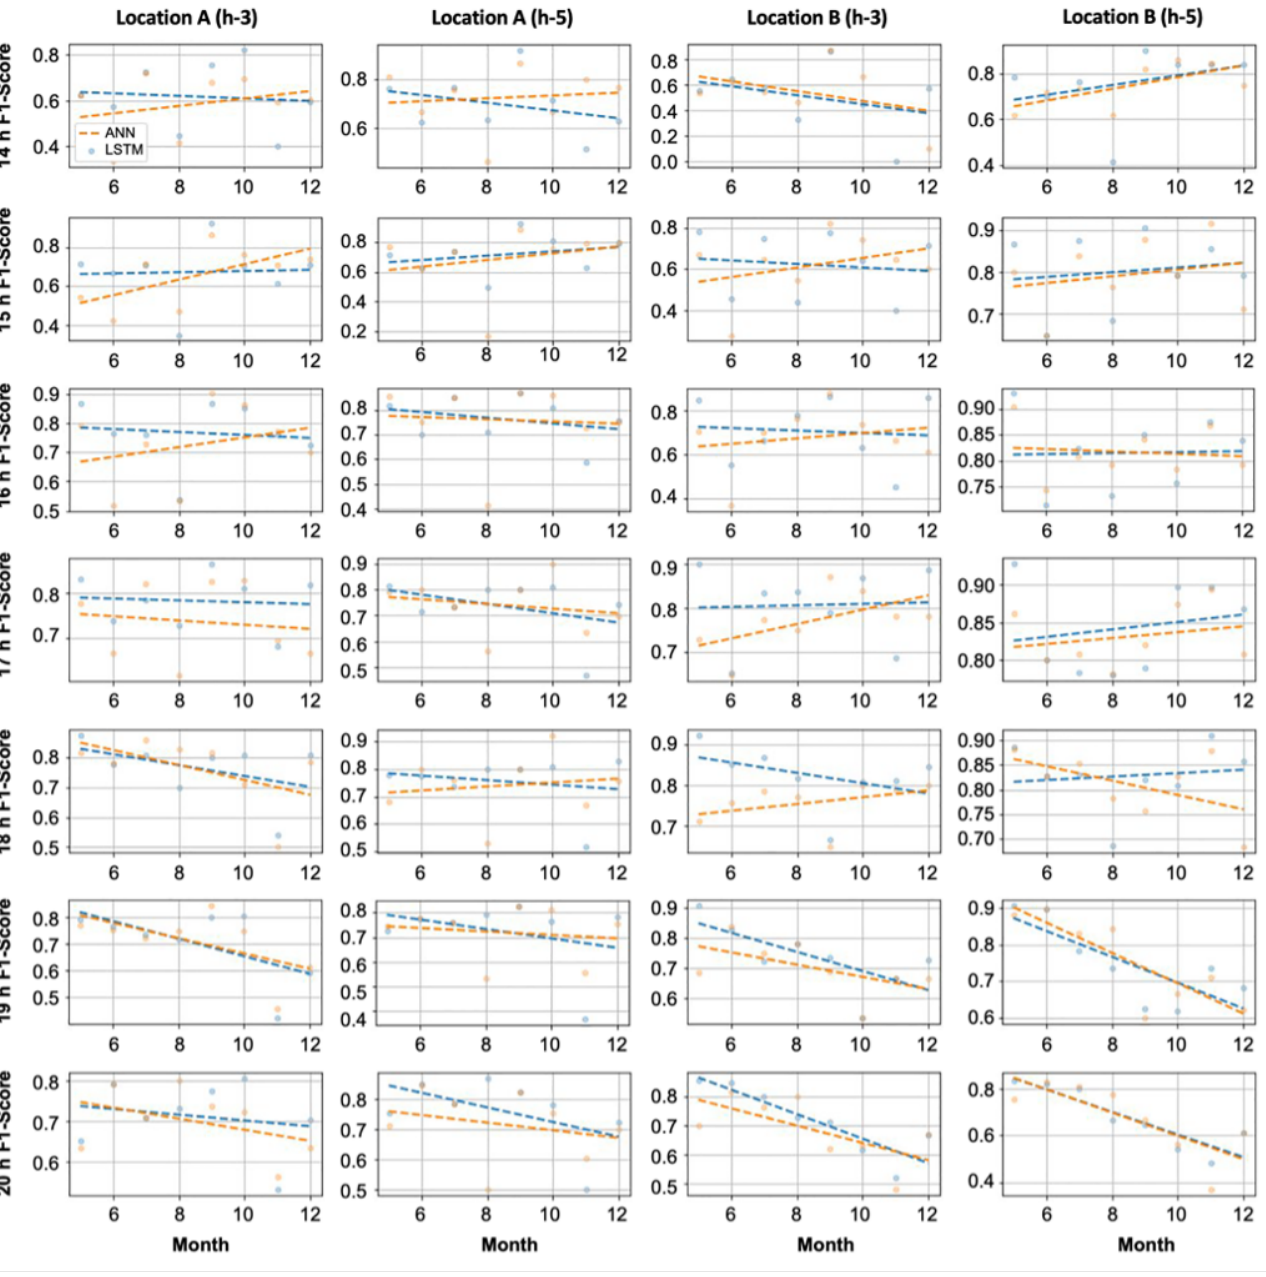
Figure 8. Hourly F1-score performance analysis of the LSTM and